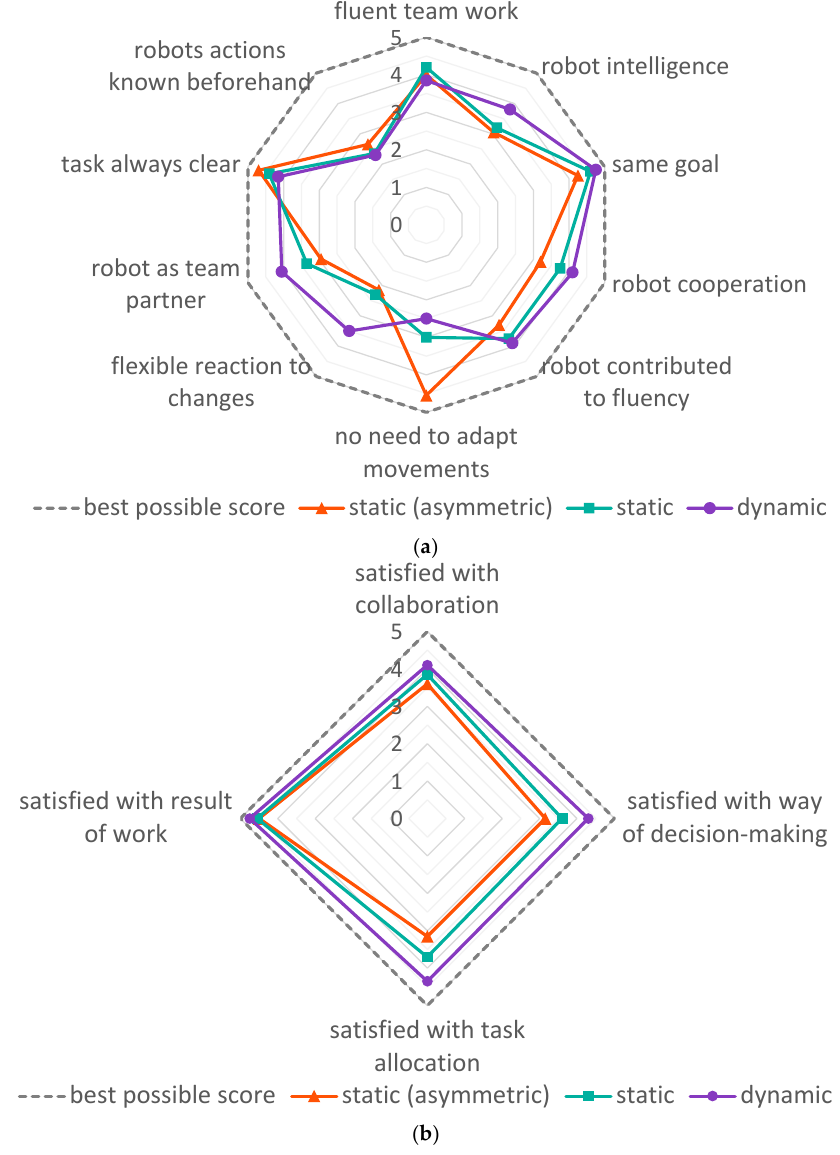
Figure 21. Detailed assessment of fluency and satisfaction in spider diagrams. ( a ) Fluency assessment. Questions with reversed scales were worded positively for illustration in spider diagram and the point value was reversed. ( b ) Satisfaction assessment.